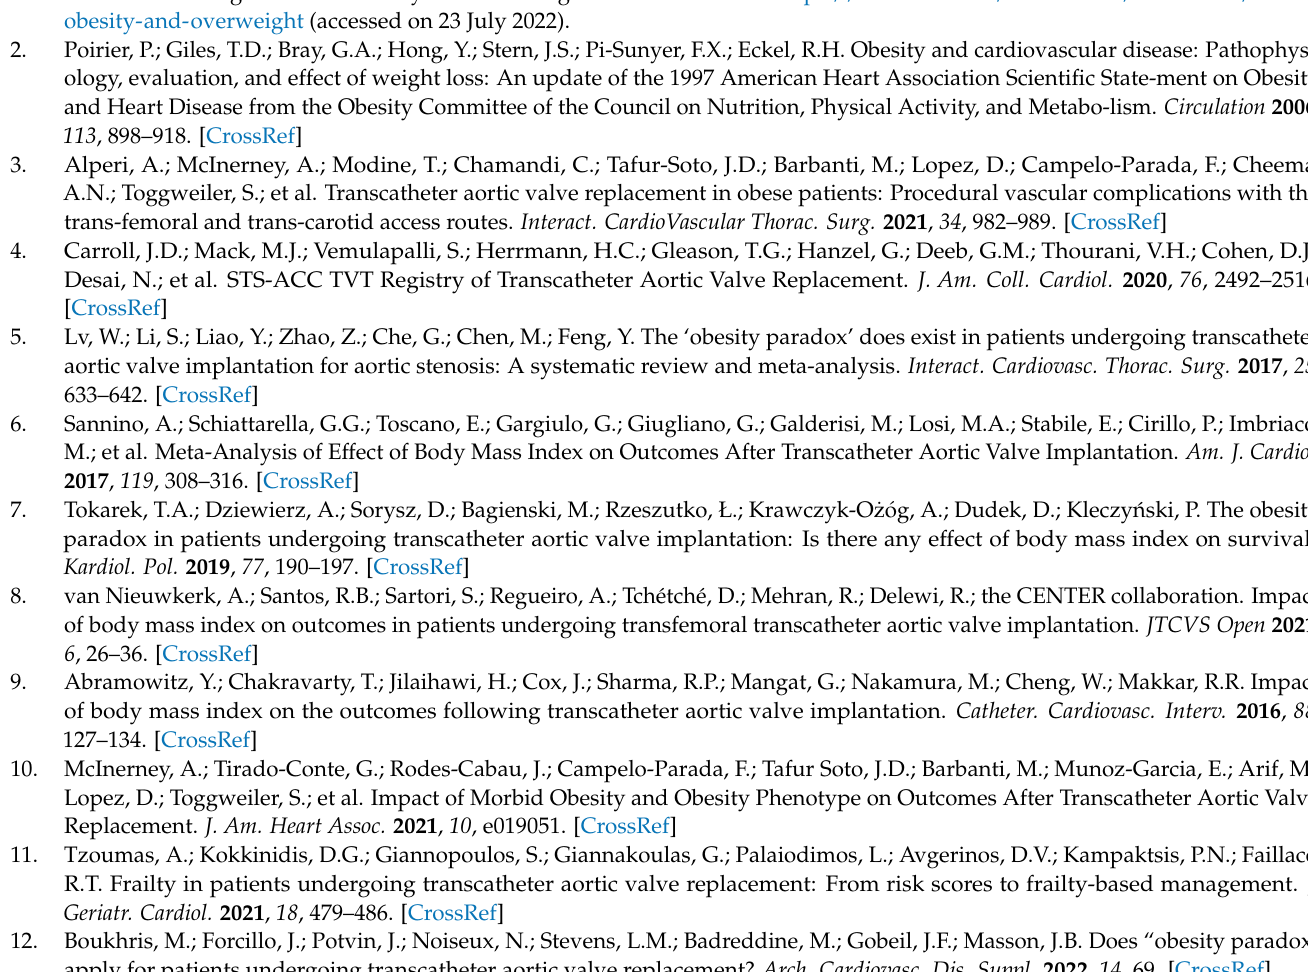
Figure S1. Funnel plots for mortality outcomes in normal BMI (Nl) versus patients with overweight (OW); Figure S2. Funnel plots for mortality outcomes in normal BMI (Nl) versus patients with obesity